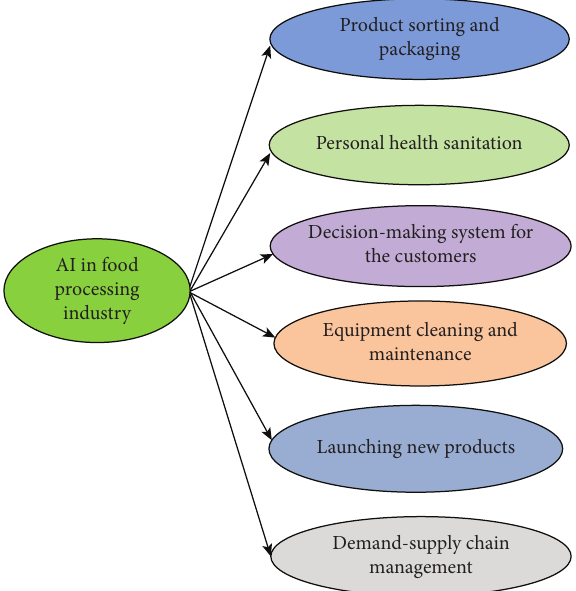
Figure 4: Important applications taken from food processing and handling industry.